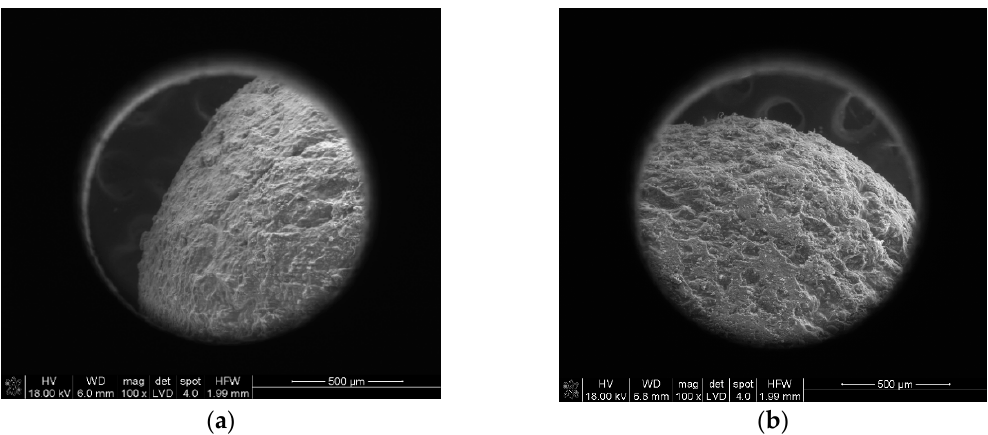
Figure 2. Digital photographs of ( a ) Ben-AC-250; ( b ) Ben-AC-400.